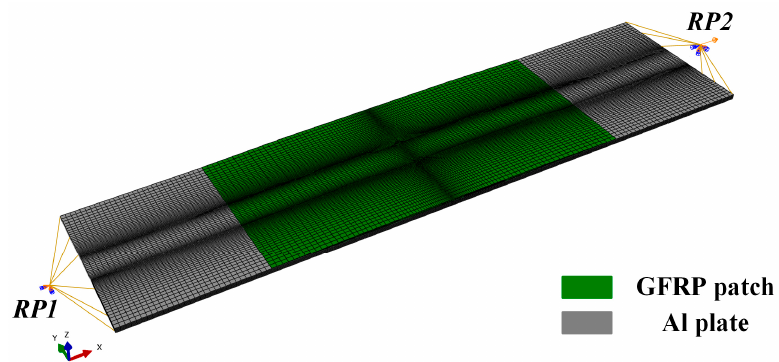
Figure 8. Finite element model for the GFRP-repaired Al plate with center-crack.